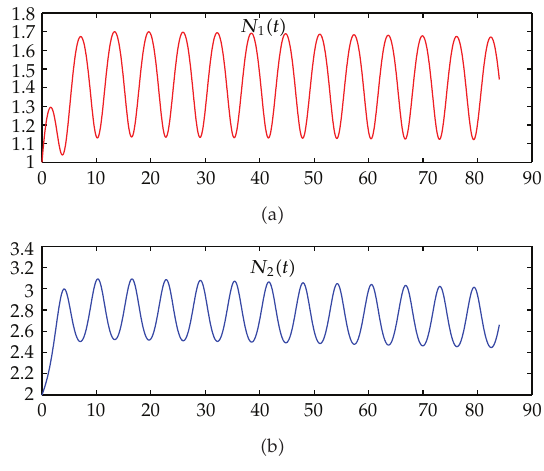
Figure 1: Numerical solution N (cid:5) t (cid:6) (cid:7) (cid:5) N 1 (cid:5) t (cid:6) ,N 2 (cid:5) t (cid:6)(cid:6) T of systems (cid:5) 3.1 (cid:6) for initial value ϕ (cid:5) t (cid:6) ≡ (cid:5) 1 , 2 (cid:6) T